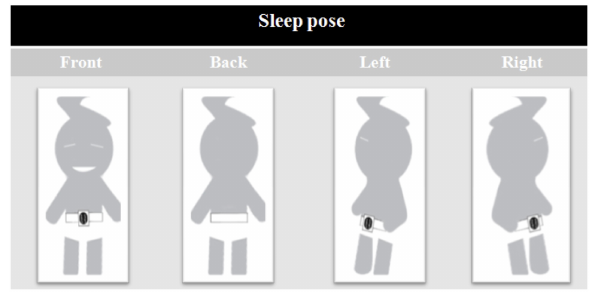
Figure 2. Sleeping